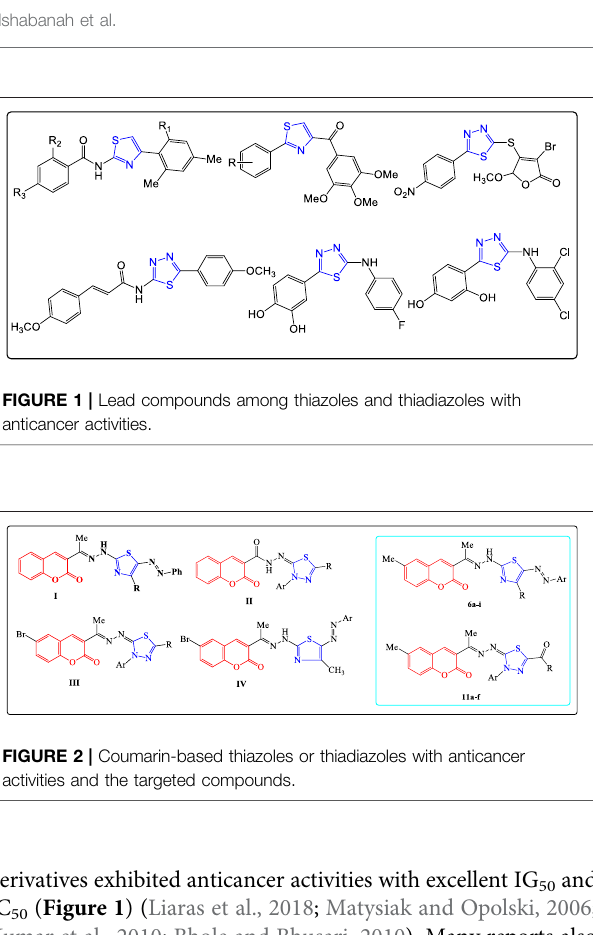
Frontiers in Chemistry |